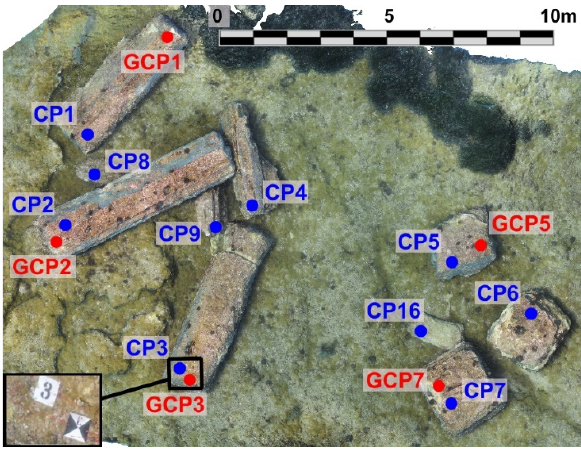
Figure 3. The eidotype of the marble blocks with GCPs and